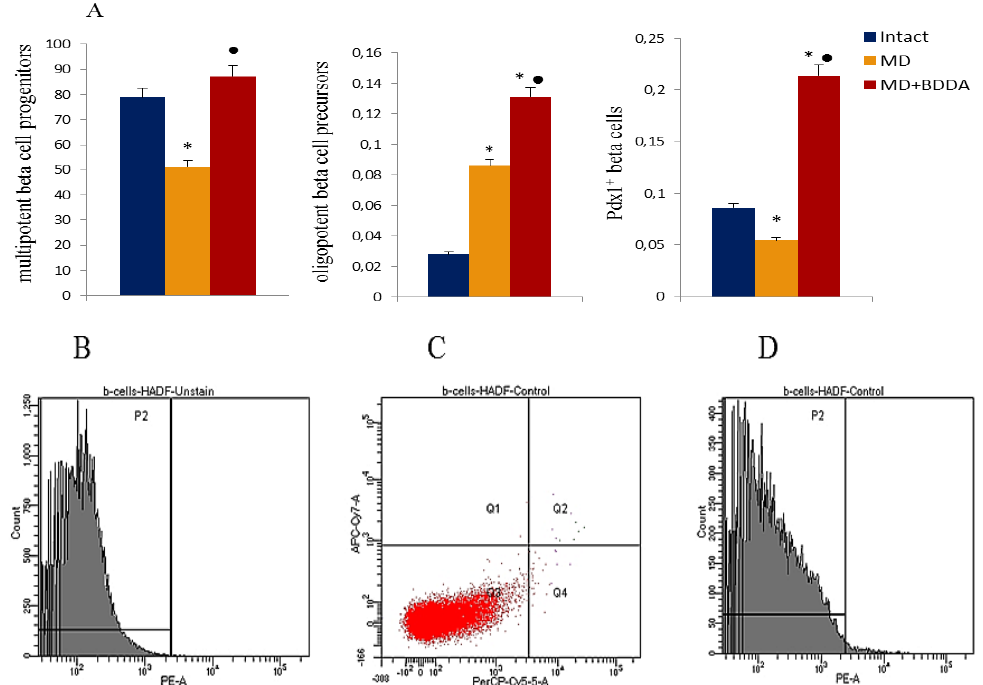
Figure 6. Characterization of multipotent beta cell progenitors (CD45 - TER119 - c-kit - Flk-1 - ), oligopotent beta cell precursors (CD45 - TER119 - CD133 + CD49f low ) and PDX1 + beta cells isolated from pancreata of male C57BL / 6 mice on d70 ( A ). Groups: intact—a control group from intact mice, MD—mice with MD, MD + BDDA mice with MD treated BDDA. Results are presented as mean ± SEM. *: significance of di ff erence compared with control ( p < 0.05); (cid:8) : significance of di ff erence compared with the MS group ( p < 0.05). Cells were analyzed by flow cytometry using antibodies against mouse CD45, TER119,